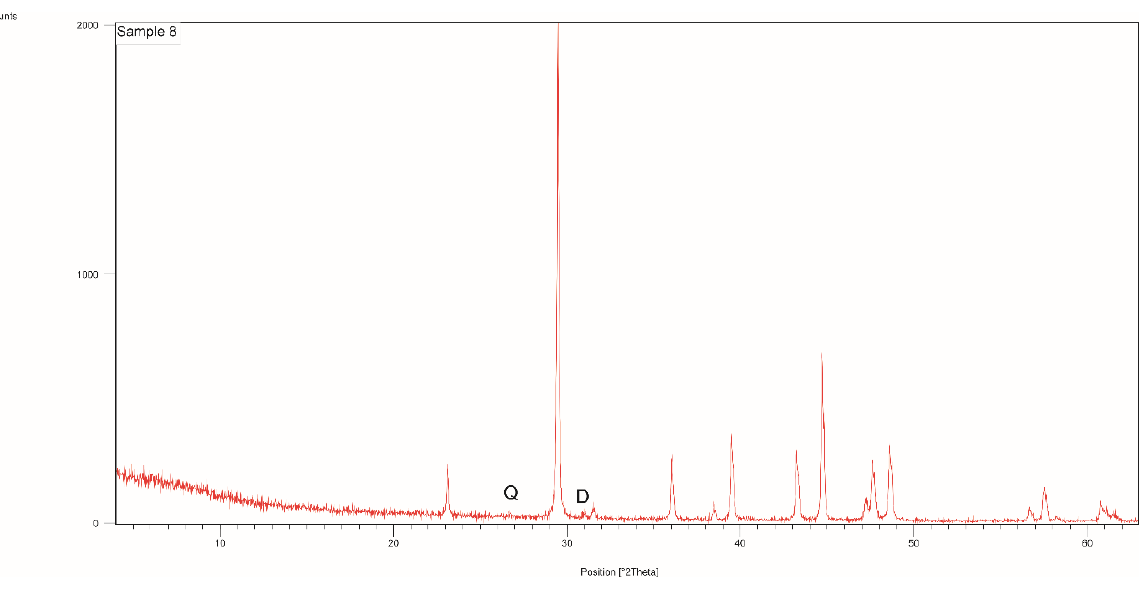
Figure A1. X-ray powder pa tt ern of sample 8 (CuK α radiation). All peaks except those at 26.65